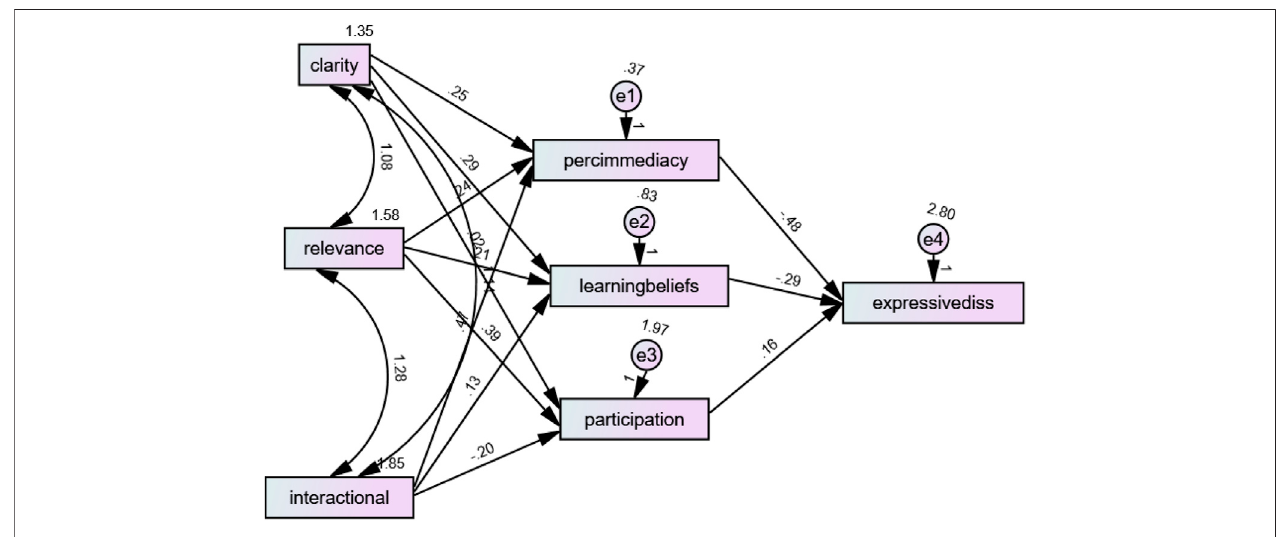
FIGURE 2 | Expressive dissent with class preference (Supported model).